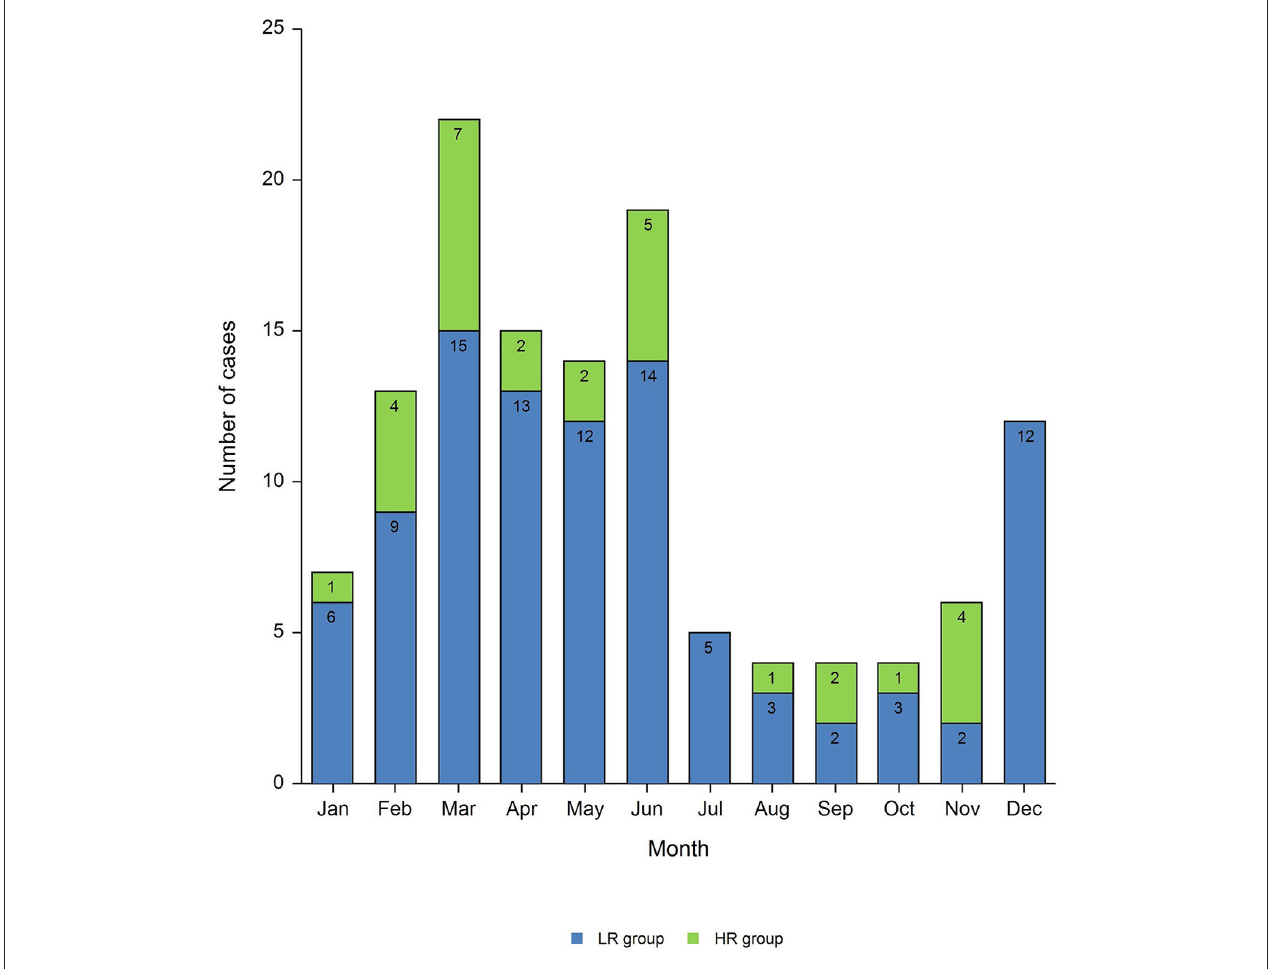
FIGURE 1 | Monthly distribution of ARF diagnoses.